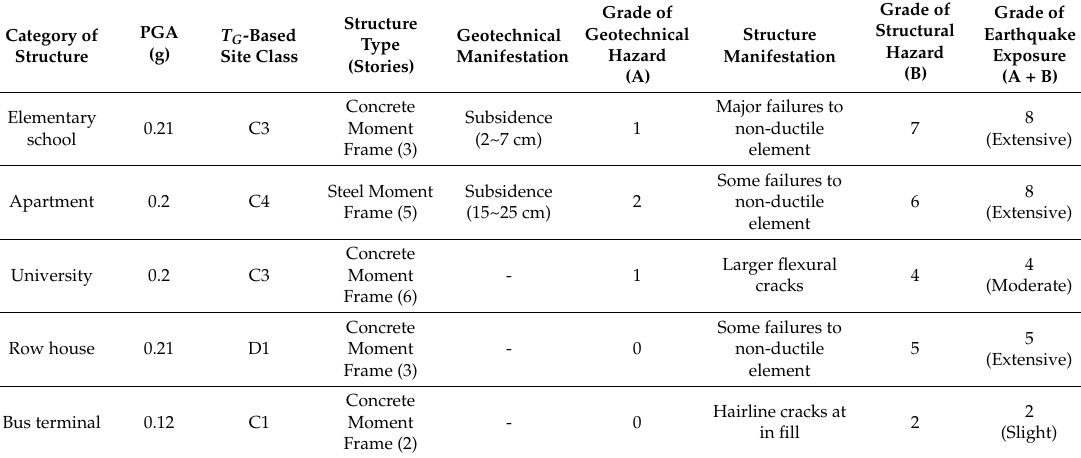
Table 4. Example of the post-earthquake impact of the 11.15 Pohang